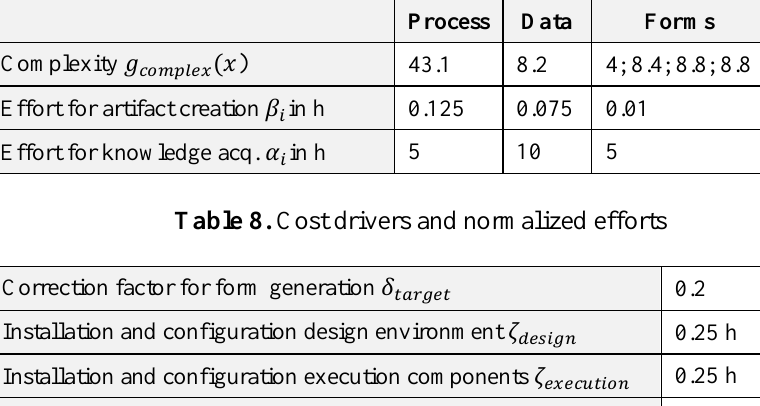
Table 7. Cost drivers and normalized efforts (design artifacts) Process Data Forms